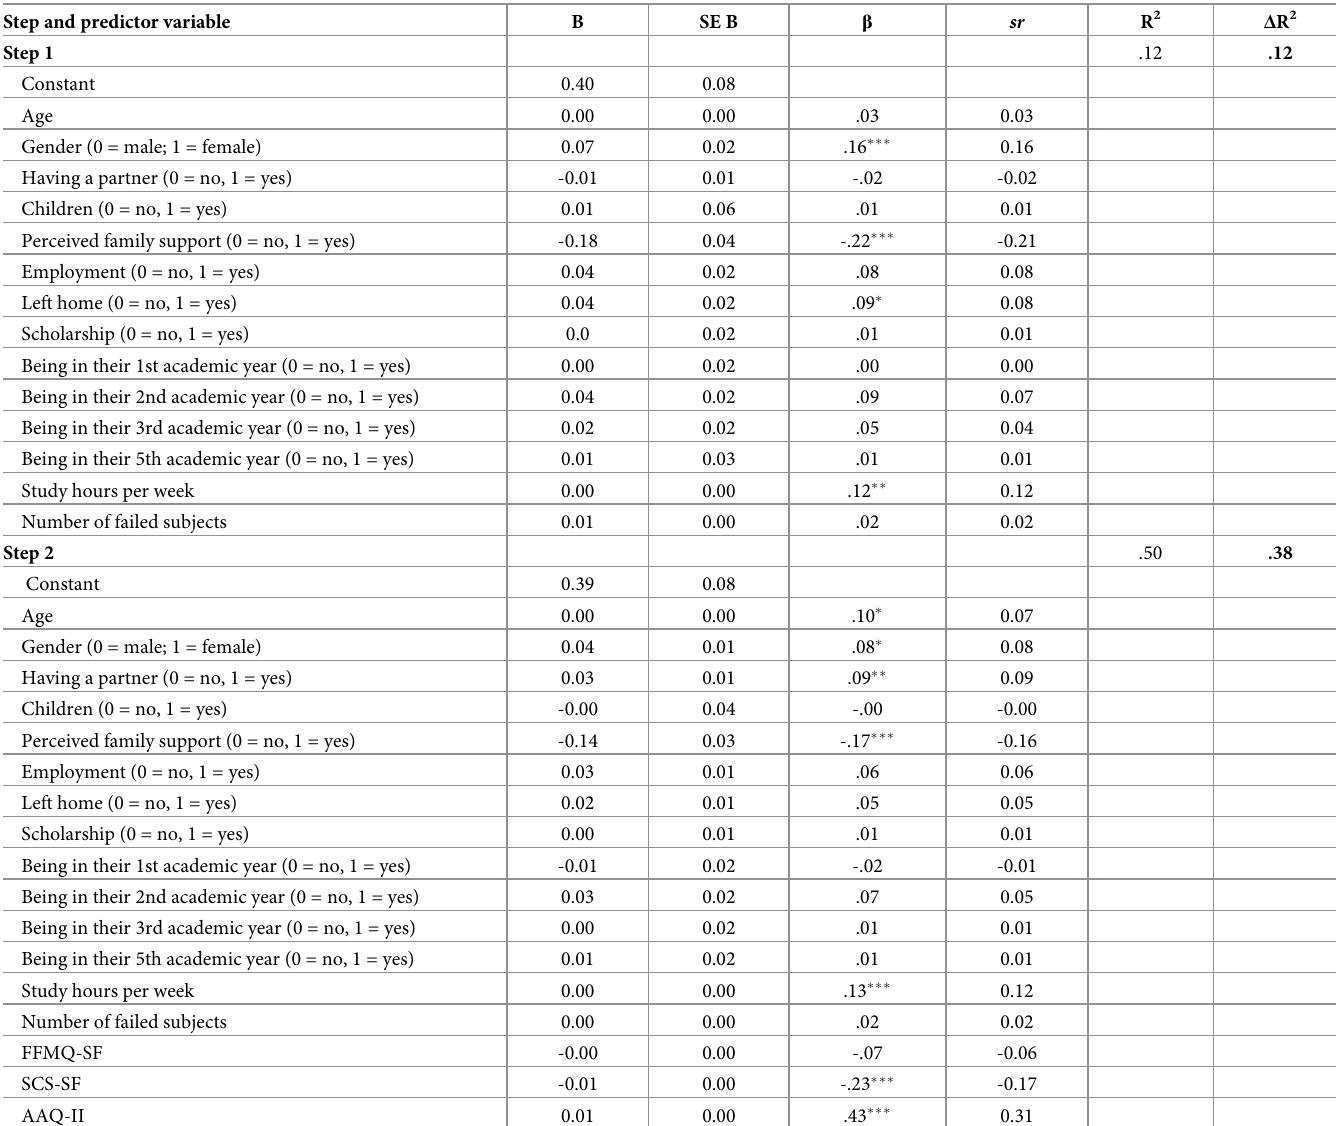
Table 2. Hierarchical multiple regression analysis summary predicting total perceived stress scores with sociodemographic, academic, and psychological